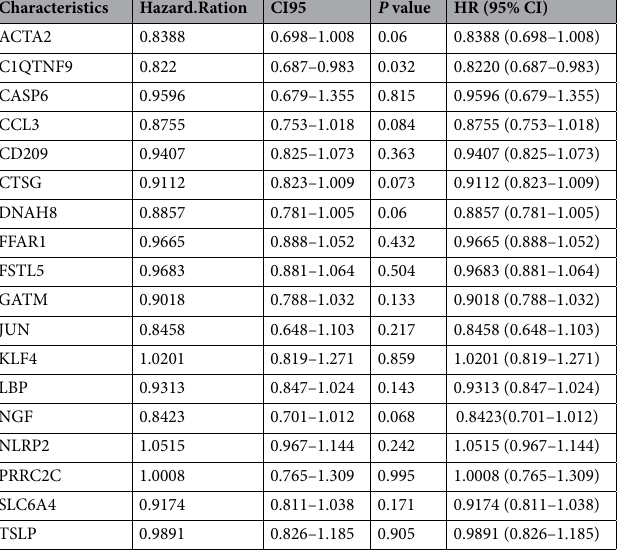
Table 2. Univariate Cox regression of 18 candidate prognostic pyroptosis and inflammasome-related